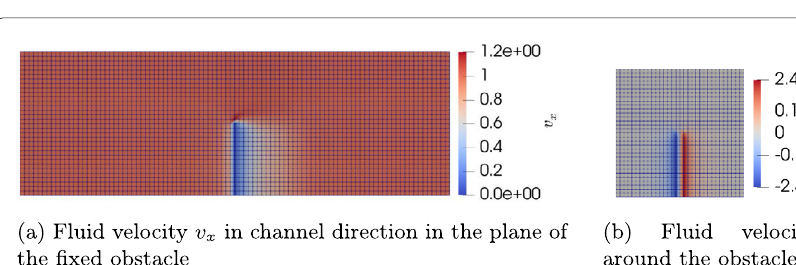
Fig. 8 Visualization of the effect of the obstacle on the fluid velocity in the channel